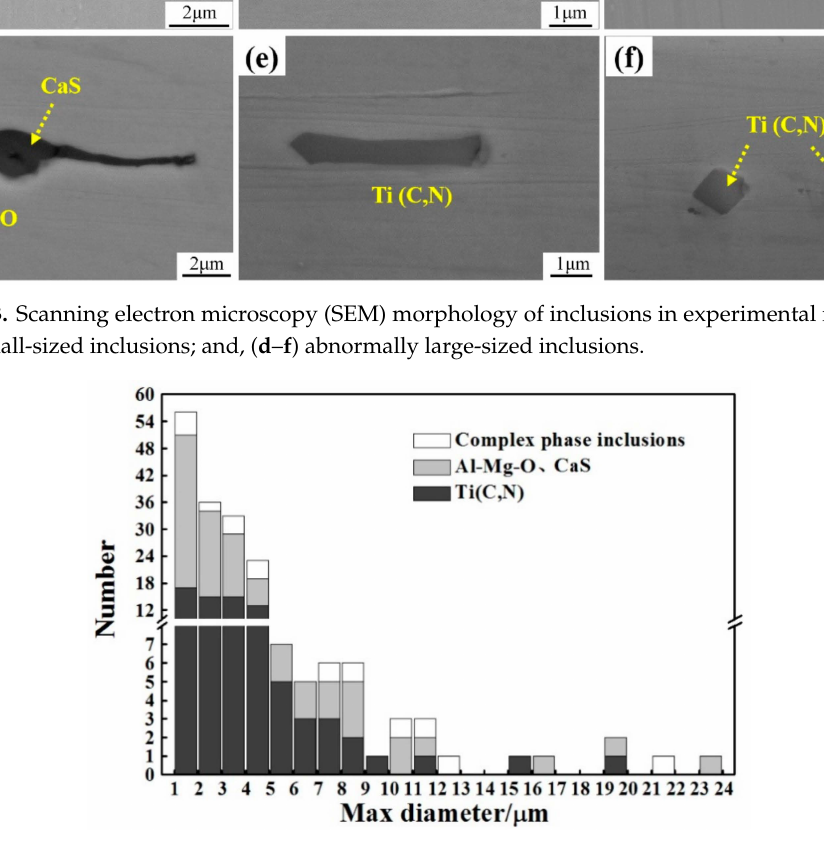
Figure 4. Statistical diagram of type and size distribution of inclusions (D max ≥ 1 µ